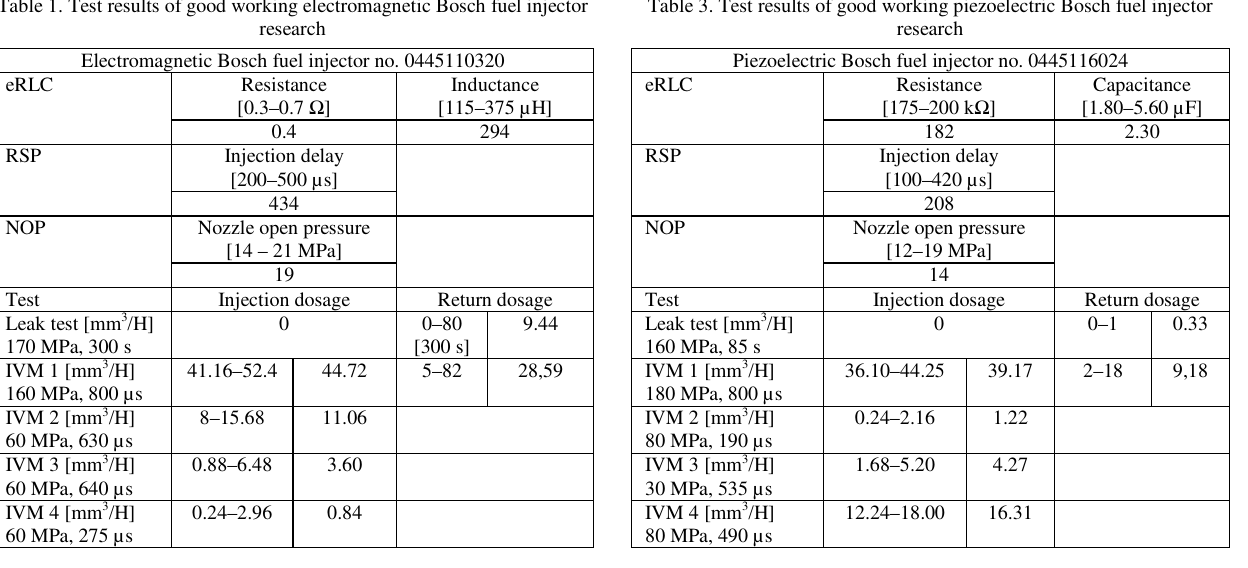
Table 4. Test results of faulty piezoelectric Bosch fuel injector research